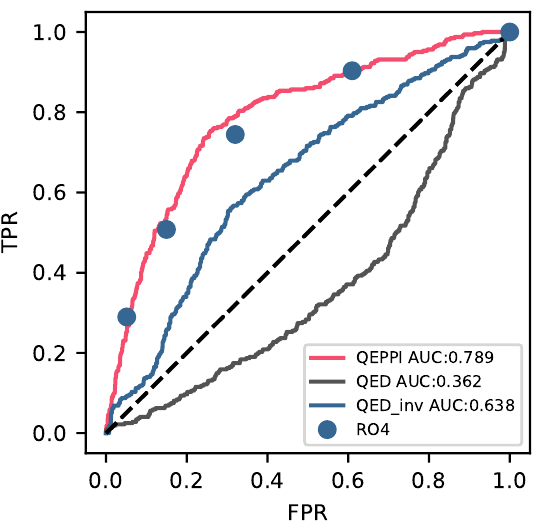
Figure 3. Comparison of QEPPI with other measures of drug-like properties in receiver operating characteristic (ROC) curves. All ROC curves show that the true-positive rate against the false-positive rate describes the differences in performance for classifying compounds as PPI-targeting compounds. The red, black, and blue lines represent the ROC curves for QEPPI, QED, and 1 − QED (QED_inv), respectively. The five blue dots are plotted as points that allowed 0 to 4 violations of RO4. The dashed black line represents a random prediction of the dataset.